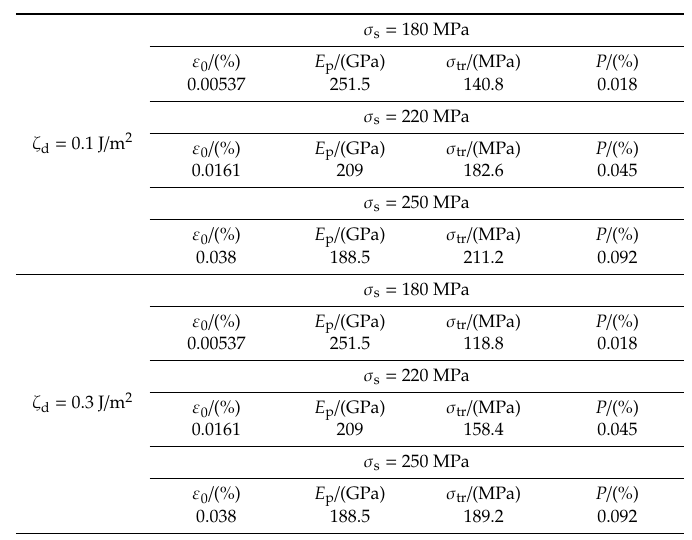
Figure 8. ( a ) The tensile stress–strain curves; ( b ) the tangent modulus versus strain curves; ( c ) the interface debonding fraction versus stress curves; and ( d ) the broken fibers fraction versus stress curves of SiC/SiC composite for conditions without stochastic loading and with stochastic loading of σ s = 180, 220 and 250 MPa when ζ d = 0.3 J/m 2 . Table 3. The effect of interface debonding energy ( ζ d = 0.1 and 0.3 J/m 2 ) on tensile stress–strain curve, tangent modulus, interface debonding fraction and broken fiber fraction of SiC/SiC composite subjected to stochastic loading of σ s = 180, 220 and 250 MPa.